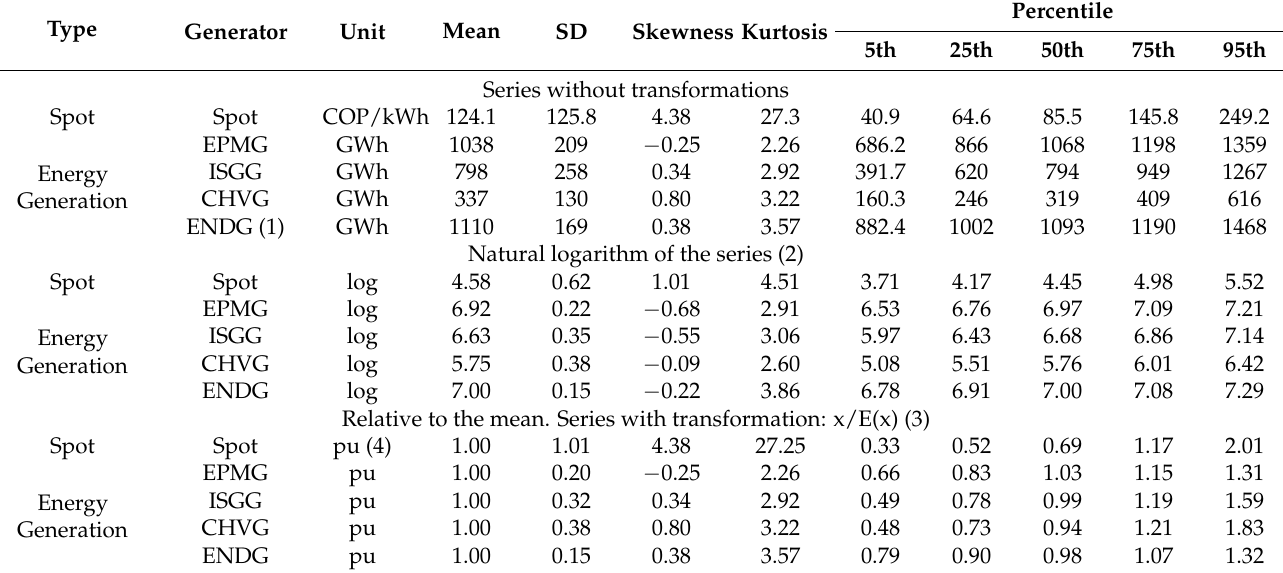
Table 1. Descriptive statistics of spot price and energy generation of each